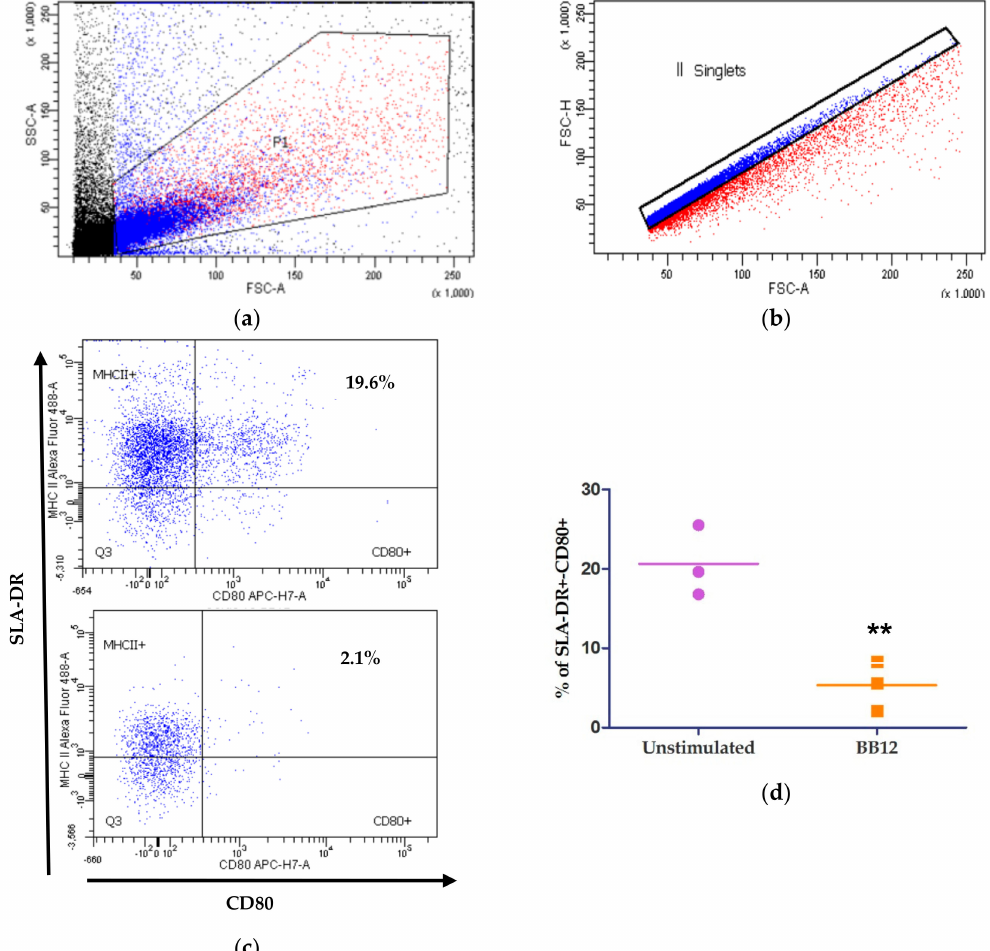
Figure 2. Percentage of SLA-DR + -CD80 + BB12-stimulated (6 h) moDCs decreased with respect to unstimulated moDCs. The phenotype of unstimulated and BB12-stimulated moDCs. Monocyte-derived DCs unstimulated (top) or stimulated with BB12 (bottom) for 6 h, stained for SLA-DR and CD80, and analyzed using flow cytometry. The cell population was first selected according to their size and complexity ( a ), then singlets were selected ( b ) and SLA-DR and CD80 were evaluated ( c ) (top graph features unstimulated moDCs and the bottom graph features BB12-stimulatedmoDCs; the dot plot is representative of n = 3). ( d ) The percentage of SLA-DR + -CD80 + BB12-stimulated moDCs (BB12) decreased with respect to the unstimulated (control) moDCs ( ** p = 0.0081). Data were analyzed using a t -test, n =